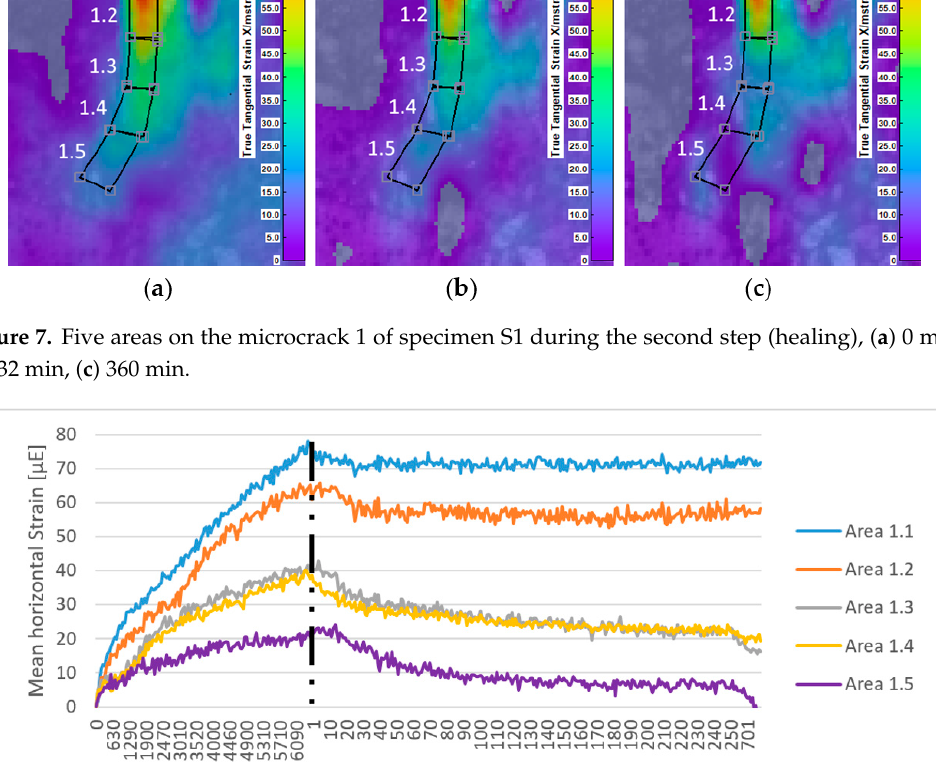
Figure 7. Five areas on the microcrack 1 of specimen S1 during the second step (healing), ( a ) 0 min, ( b ) 32 min, ( c ) 360 min. Figure 8. Mean horizontal strain on five areas of Figure 7, the vertical dash-dot line shows the stopping moment of step 1 and start of step